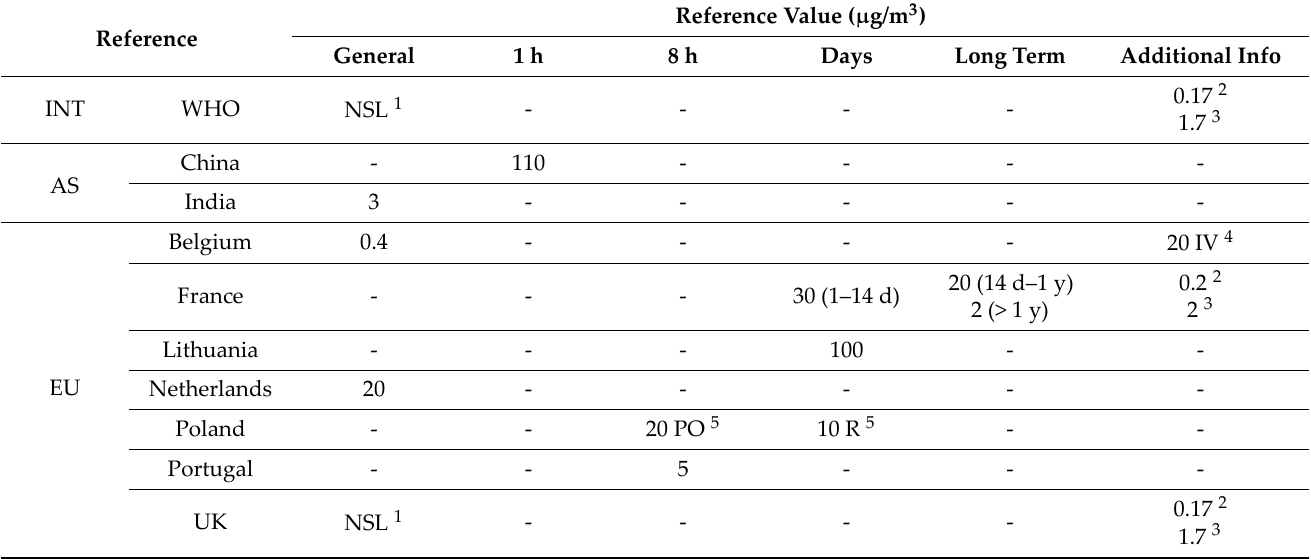
Table 4. Reference values for